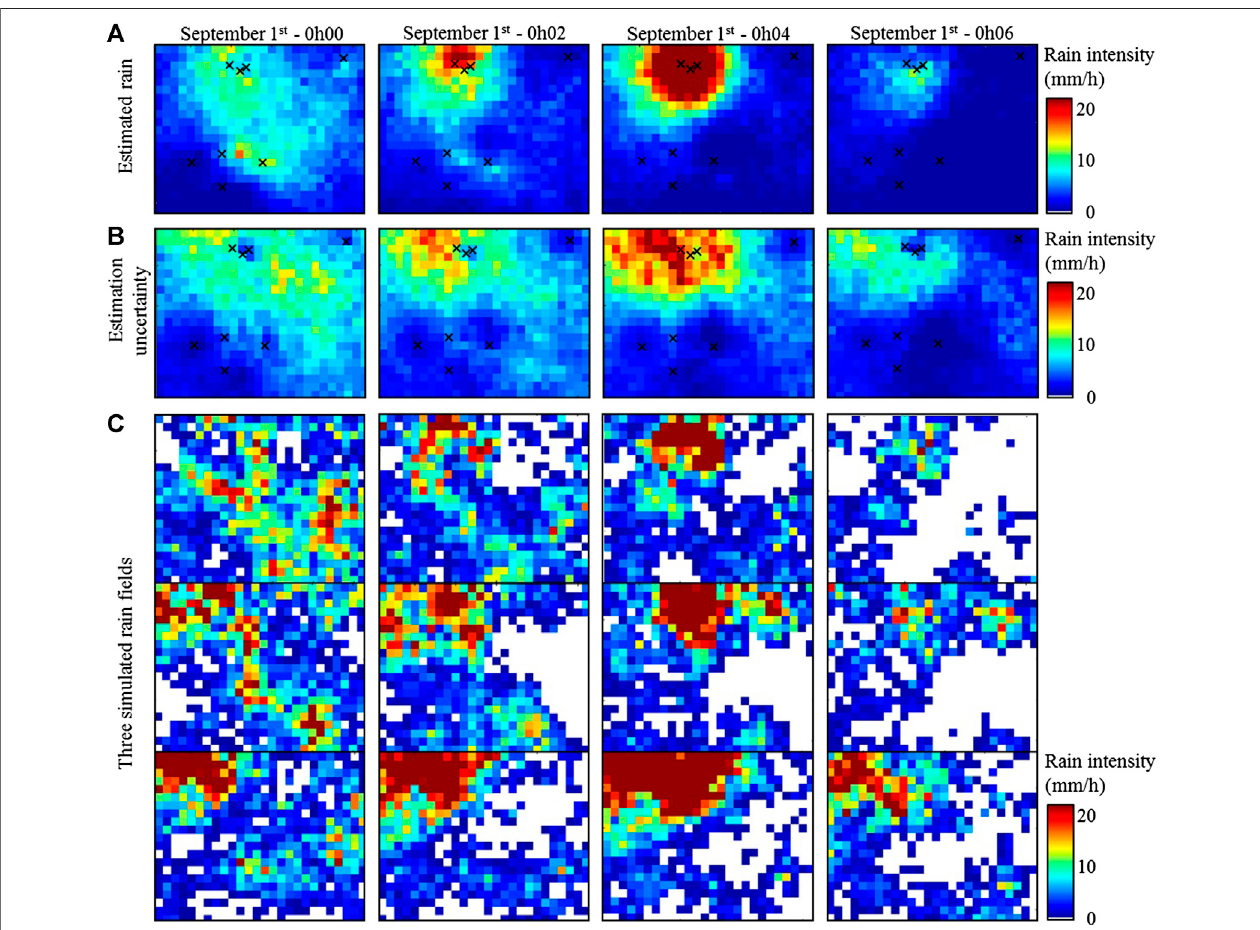
FIGURE6| Exampleofhigh-resolutionrainmapsforasmallsubsetofrainevent3,September1 st ,2019-0h00-0h06. (A) Estimatedrainfallintensity(i.e.medianof 50 realizations). (B) Uncertainty of the estimation (i.e. half Q90-Q10 range of 50 realizations). (C) Examples of three simulated rain fi elds selected amongst the 50 realizations used to derive (A) and (B) . In (A) and (B) , black crosses denote active rain gauges. For visualization purposes results presented here are aggregated to a 2- min resolution; rain movies at full resolution (1 min) are available in supplementary material.